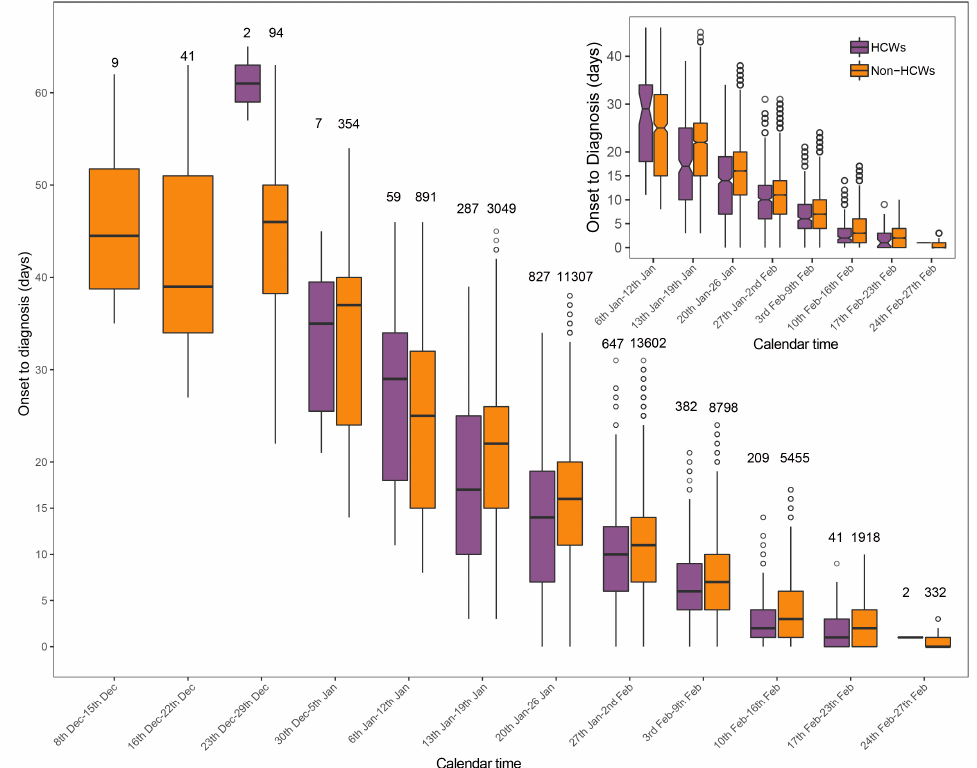
Figure 1. Time interval from symptom onset to diagnosis against calendar time among healthcare workers (HCWs) and non-HCW cases of COVID-19 in Wuhan. The case number in each group was shown over each box in the main figure. From 6 January 2020, the box plot was shown with notches in smaller scale, which represent the 95% confidence intervals of medians of time from symptom onset to diagnosis.